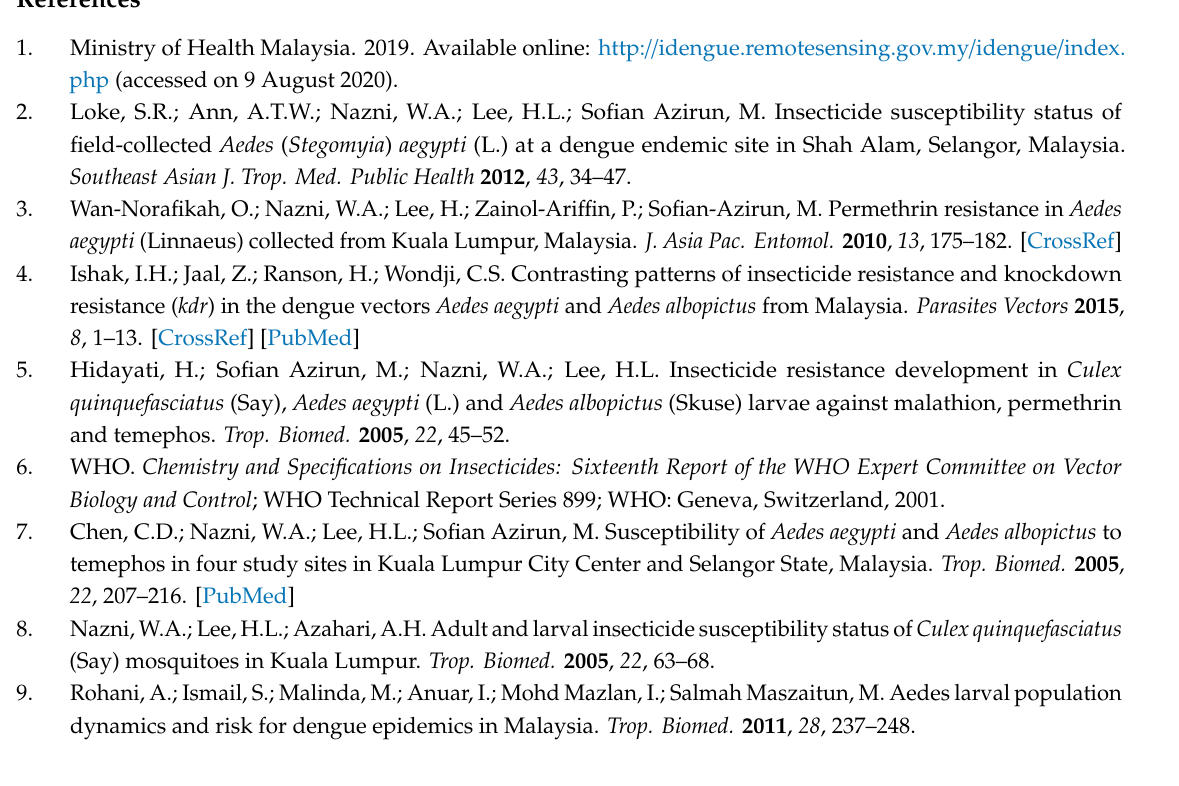
Table S1: Test for Hardy–Weinberg equilibrium of genotypes at three Vssc mutation sites in Aedes aegypti from the field (Shah Alam), the laboratory (B3F3 IMR) and bioassayed female individuals (dead and alive); Supplementary Material S1: DNA sequences for 27 individuals of Aedes albopictus for a small section of the voltage-sensitive sodium channel gene (Vssc) from S6, domain III from Shah